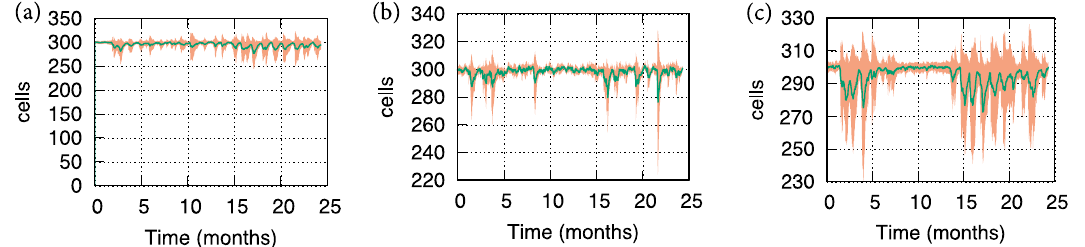
Figure 2. Oligodendrocyte (ODC) dynamics revealed by 20 simulation cases of MS virtual patients. Green lines depict the mean behavior, while the shaded region refers to ± SD. In panel ( a ), simulated MS patients show a slight loss of oligodendrocyte levels. This prediction has been obtained assigning to the factors identified by Rotstein and Montalban input values that are correlated with low severity of MS prognosis. In panel ( b ), simulated MS patients show a medium loss of oligodendrocyte levels. This prediction has been obtained assigning to the factors identified by Rotstein and Montalban input values that are correlated with medium severity of MS prognosis. Finally, in panel ( c ) simulated MS patients show a high loss of oligodendrocyte levels. This prediction has been obtained assigning to the factors identified by Rotstein and Montalban input values that are correlated with high severity of MS prognosis.